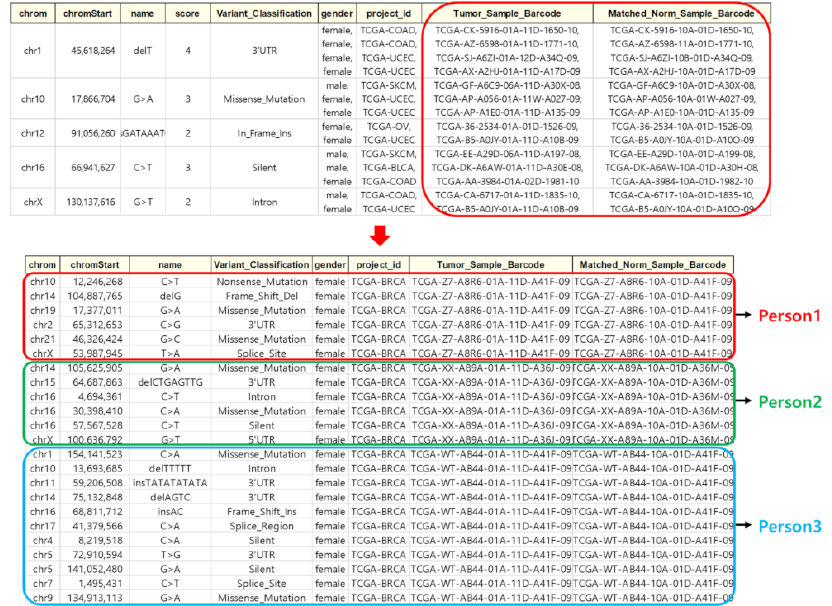
Figure 7. Classified by individual genomic